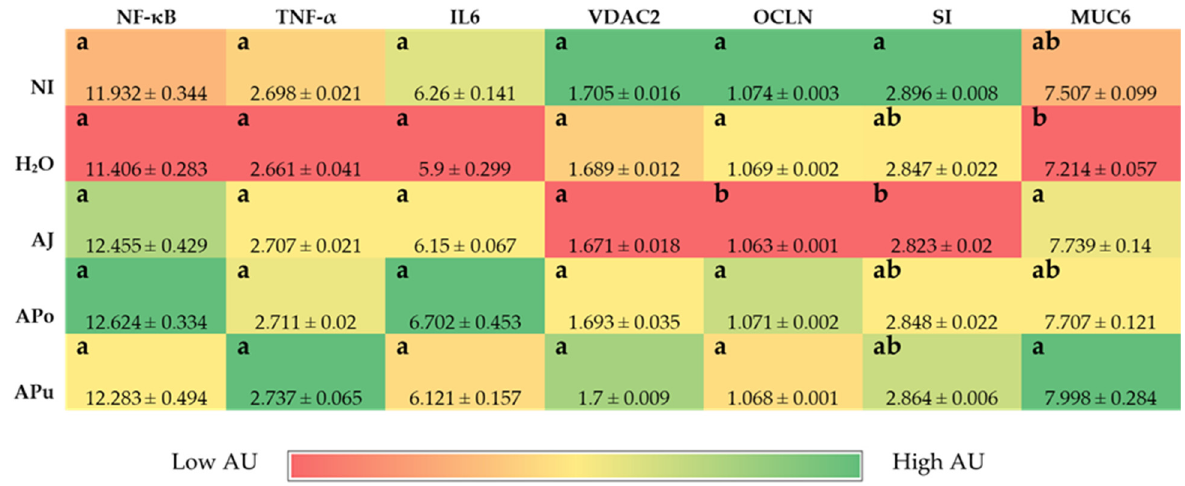
Figure 3. Effect of intra-amniotic administration of apple fraction soluble extracts on inflammatory and functional intestinal protein gene expression. Values are the means ± SEM, n = 5. a, b Treatment groups not indicated by the same letter in the same column are significantly different ( p < 0.05) by Duncan’s post-hoc test. NF-kB, Nuclear factor kappa beta; TNF- α , Tumor necrosis factor-alpha; IL6, Interleukin 6, VDAC2, Voltage-dependent anion channel 2; OCLN, Occludin; SI, Sucrase isomaltase; MUC6, Mucin 6; AU, Arbitrary units.